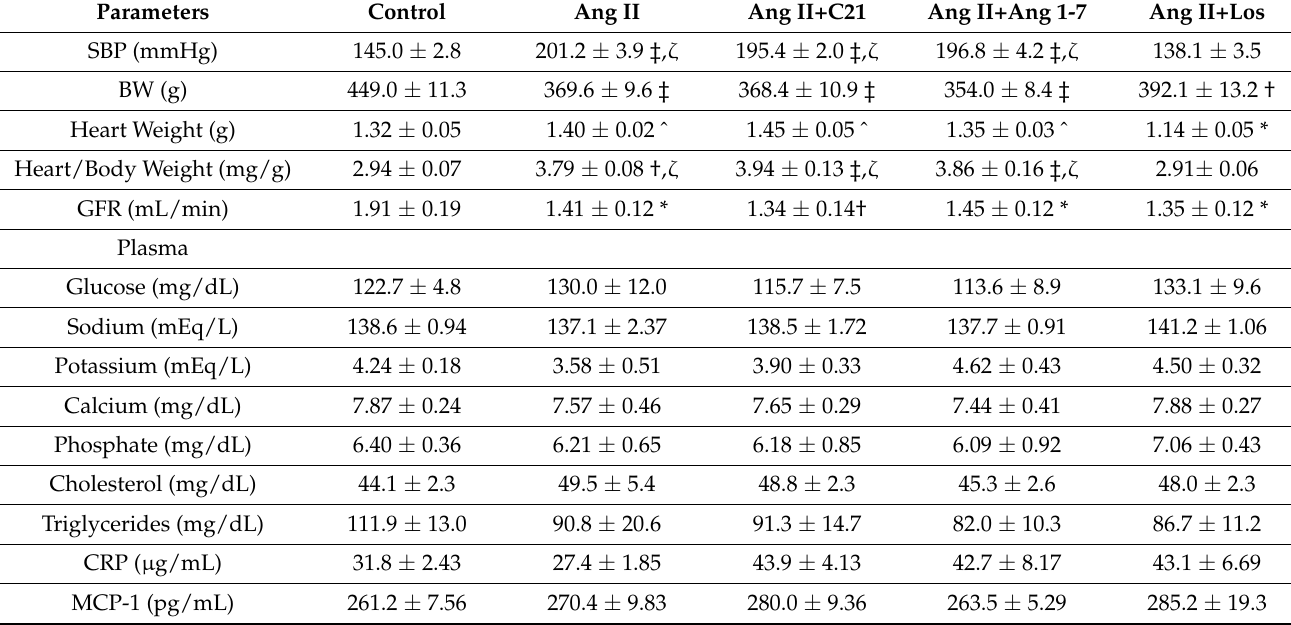
Table 2. Systolic blood pressure (SBP, mmHg), body weight (BW, g.), heart weight (g.), heart/body weight ratio (mg/g), glomerular filtration rate (GFR, mL/min); non fasting plasma glucose (mg/dL), sodium (mEq/L), potassium (mEq/L), calcium (mg/dL), phosphate (mg/dL), total cholesterol (mg/dL), triglycerides (mg/dL), C reactive protein (CRP, µ g/mL) and monocyte chemoattractant protein (MCP-1, pg/mL) in Control ( n = 5), Ang II ( n = 5), Ang+C21 ( n = 6), Ang II+Ang 1-7 ( n = 7), Ang II+Los ( n = 7)-treated rats at the end of the long-term experimental period (4